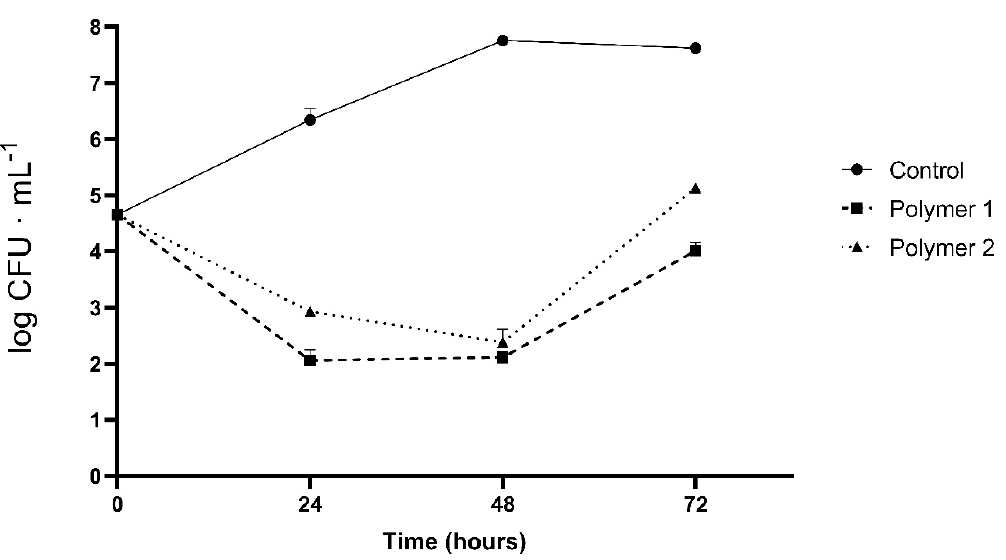
Figure 4. Antibacterial activity of polymers against Escherichia coli over 72 h of incubation. Control: growth without polymer. Polymer 1: polymer formulated with chitosan only. Polymer 2: polymer formulated with chitosan and fish gelatin. The results are expressed as log CFU ml.